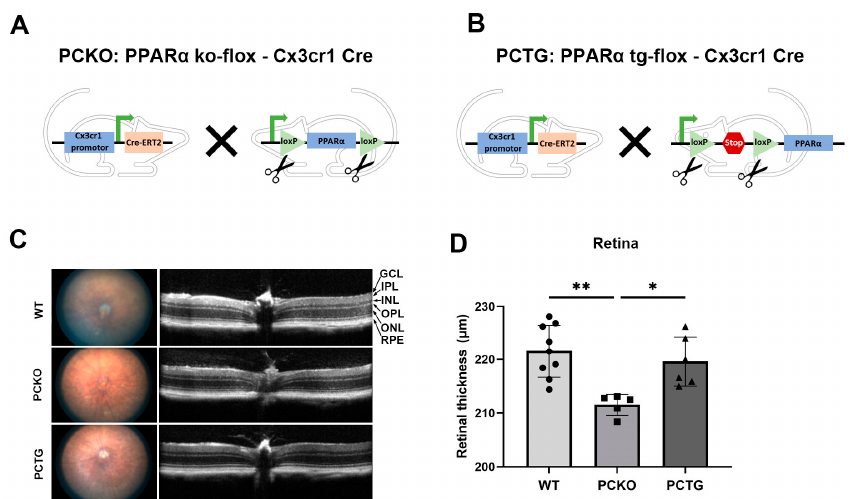
Figure 2. Decreased retinal thickness in PCKO mice. ( A , B ) Diagrams of PCKO-Cx3Cr1Cre ( A ) and PCTG-Cx3Cr1Cre ( B ) mouse lines constructs. ( C ) Representative retina fundus and OCT images of non-diabetic WT, PCKO, and PCTG mice (8 months of age). ( D ) Total retinal thickness quantified by OCT. n = 5–9. * p < 0.05, ** p < 0.01, One-way ANOVA with Tukey’s posthoc comparison. Abbreviations: IPL: inner plexiform layer, INL: inner nuclear layer; OPL: outer plexiform layer, ONL: outer nuclear layer; GCL: ganglion cell layer; RPE: retinal pigment epithelium, WT: wild-type, PCKO: